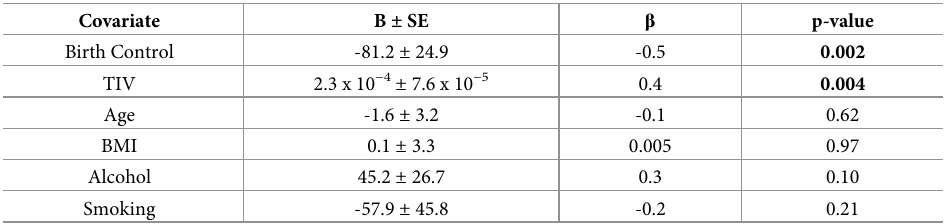
Table 2. Regression model for hypothalamic volume.